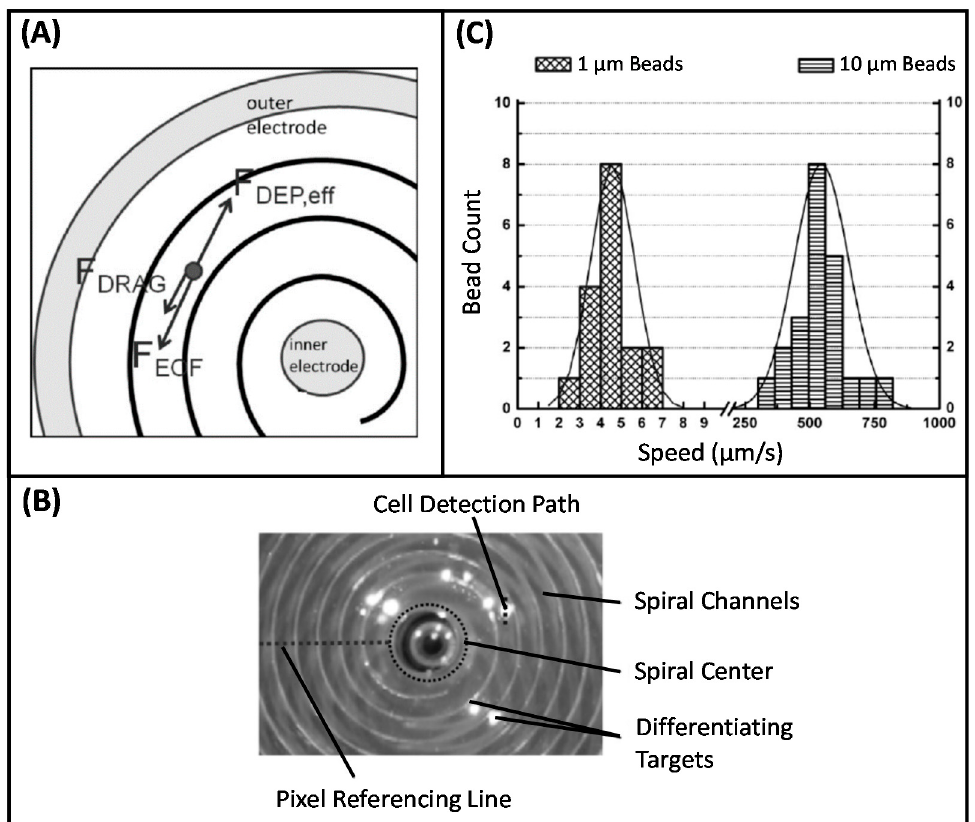
Figure 6. ( A ) Electrokinetic forces acting on the particles throughout their movement in the spiral channel. ( B ) Snapshot of recorded video processed using Image J to examine the speed histogram of 10 μ m polystyrene particles. ( C ) Comparative histogram of extracted speeds of 1 and 10 μ m beads. The number of beads is given with the data bars. The straight lines correspond to the best Gaussian fits. Results show that 1 μ m and 10 μ m particles have an average speed of 4.57 μ m/s and 544 μ m/s, respectively [259]. Copyright 2010, John Wiley and Sons.